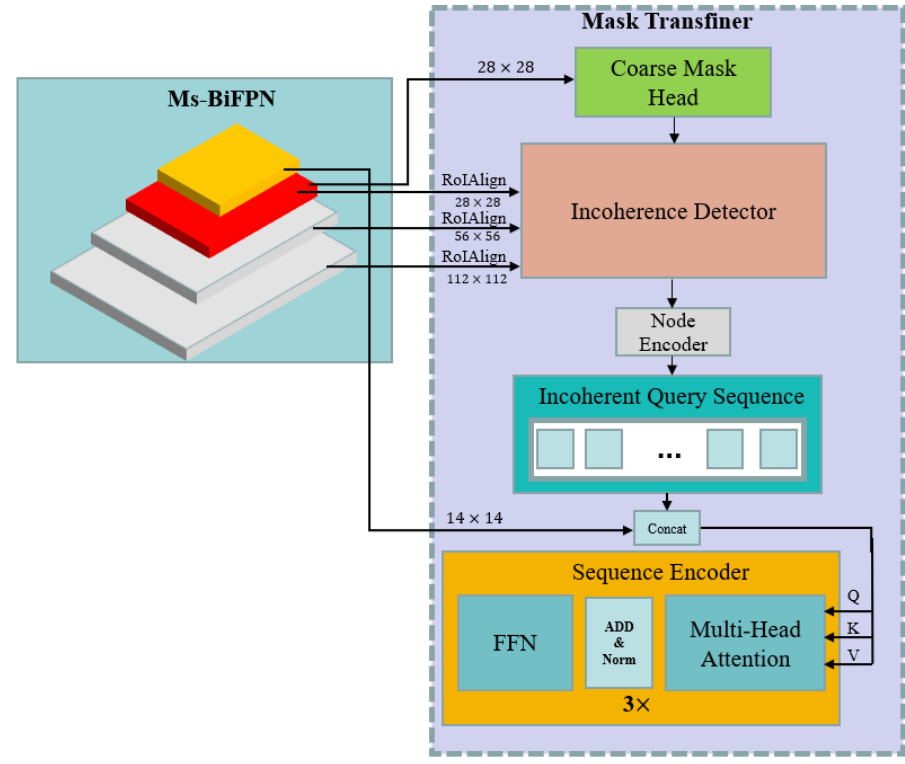
Figure 8. The architecture of Mask Transfiner.